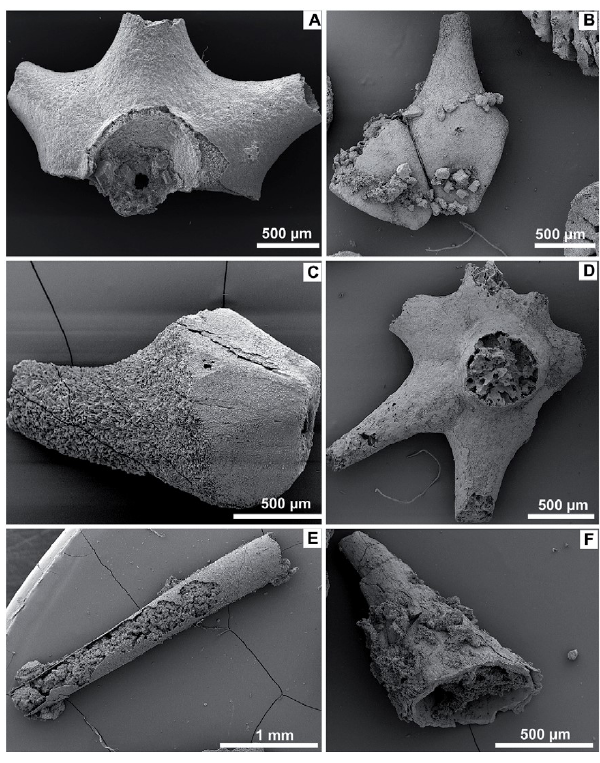
Fig. 5. Mankhan-Uul phosphorite deposit, left-bank of the Egiingol river. Problematical discoidal and circular bacterial remains of Chuaria sp. and Aspidella-like imprint from the Kheseen Formation of the Khuvsgul phosphate basin. Photograph by 05.08.2019.